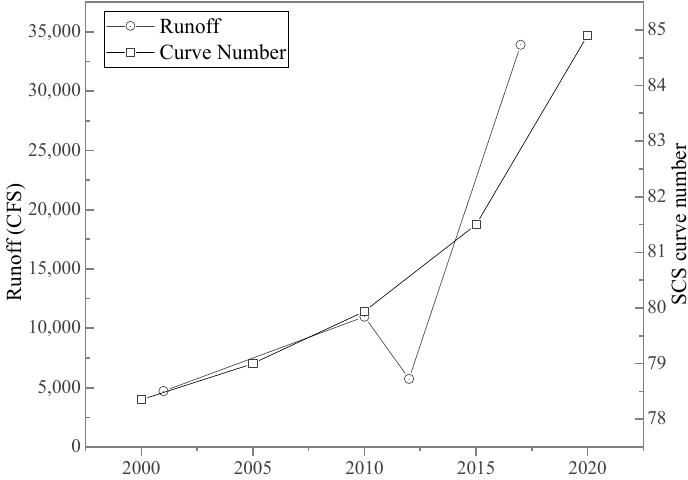
Figure 11. Relation between SCS curve number and peak runoff discharge. Table 4. Runoff generation for different climate/land ‐ use scenarios.